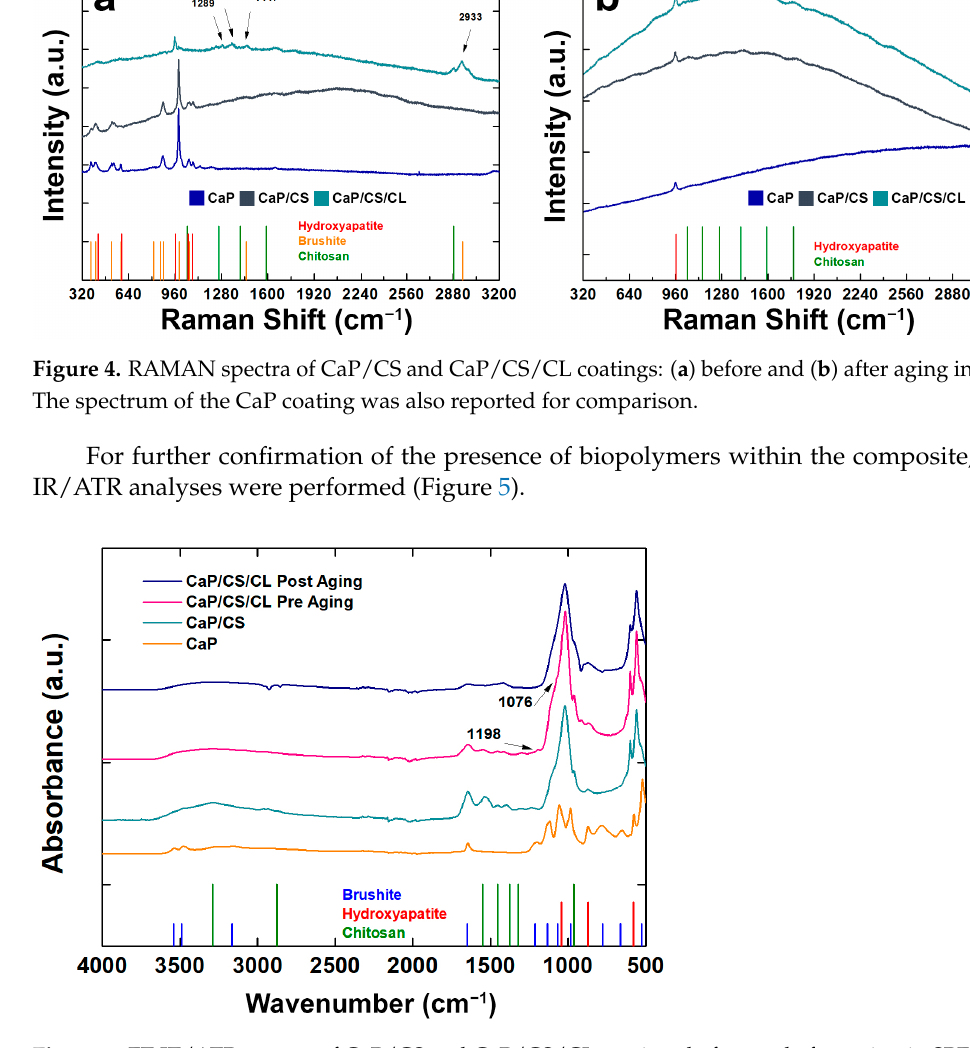
Figure 5. FT-IT/ATR spectra of CaP/CS and CaP/CS/CL coatings before and after aging in SBF. The spectrum of the CaP coating was inserted for comparison.